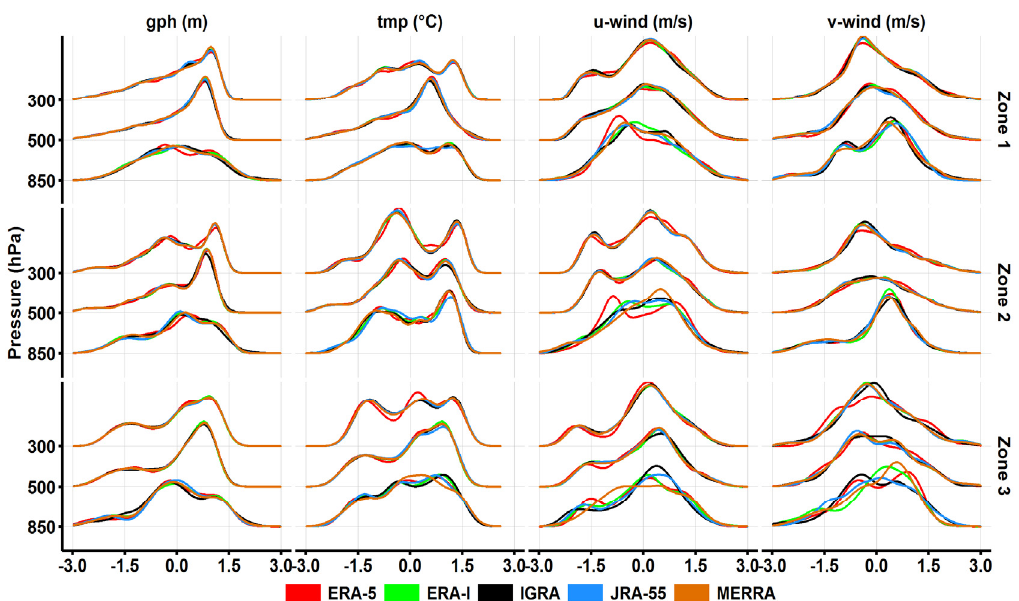
Figure 5. Probability distribution function (PDF) of the vertical profiles of gph (m), tmp (°C), and horizontal wind (m/s) at annual scale.